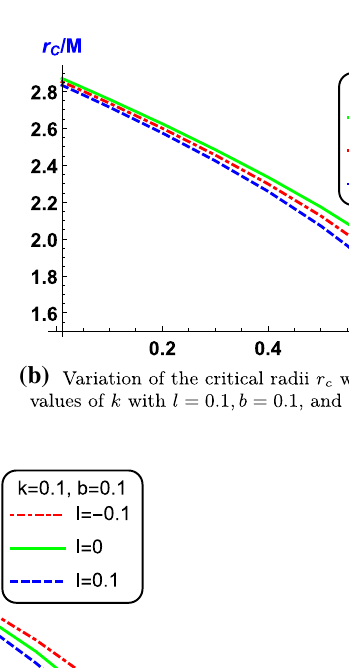
Fig. 1 Plots of the effective potential for various scenarios